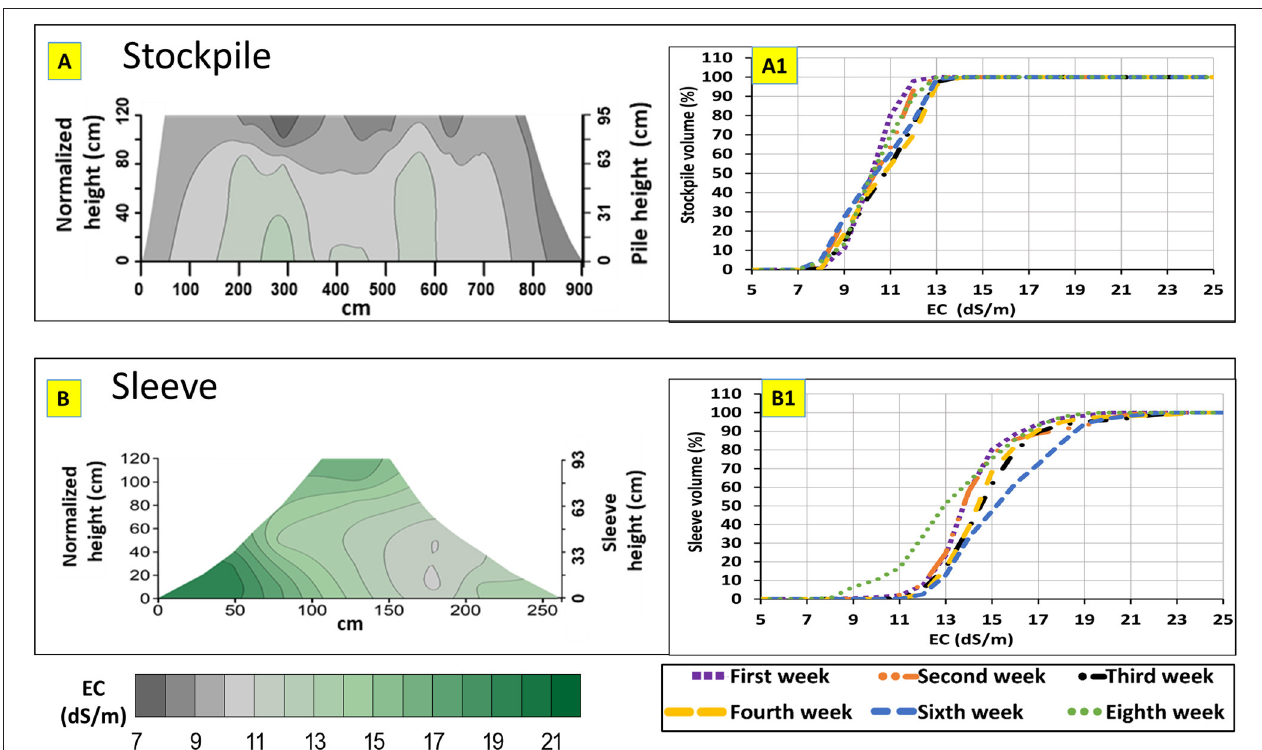
FIGURE 5 | Spatial–temporal variation of EC (dS m − 1 ). Contour maps (week 1) and the cumulative volumetric percentage of EC in the stockpile (A,A1) and the sleeve ( B ; cross-section II, B1 ; weighted average of cross-sections